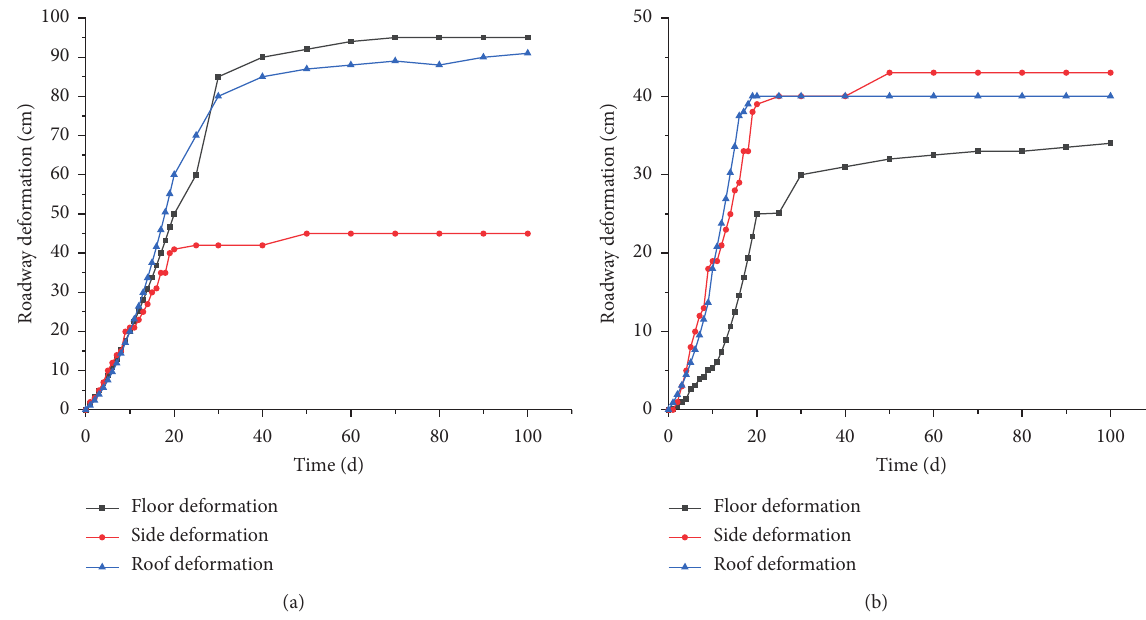
Figure 12: Displacement-time curves of roadway surrounding rock. (a) Deformation of the control section of the roadway. (b) Roadway deformation in the test